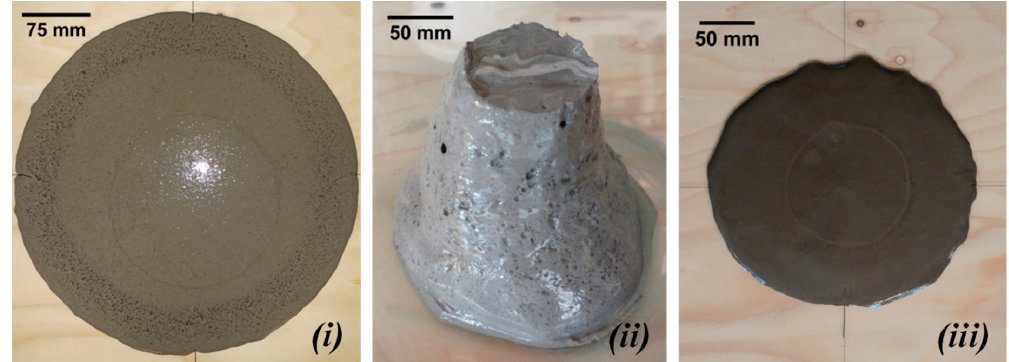
Figure 6. The mini-slump spread test for ( i ) S0 (alkali-activated FA paste), ( ii ) S100 (alkali-activated GBFS paste), and ( iii ) CEM I 42.5 N paste for l/b = 0.5.